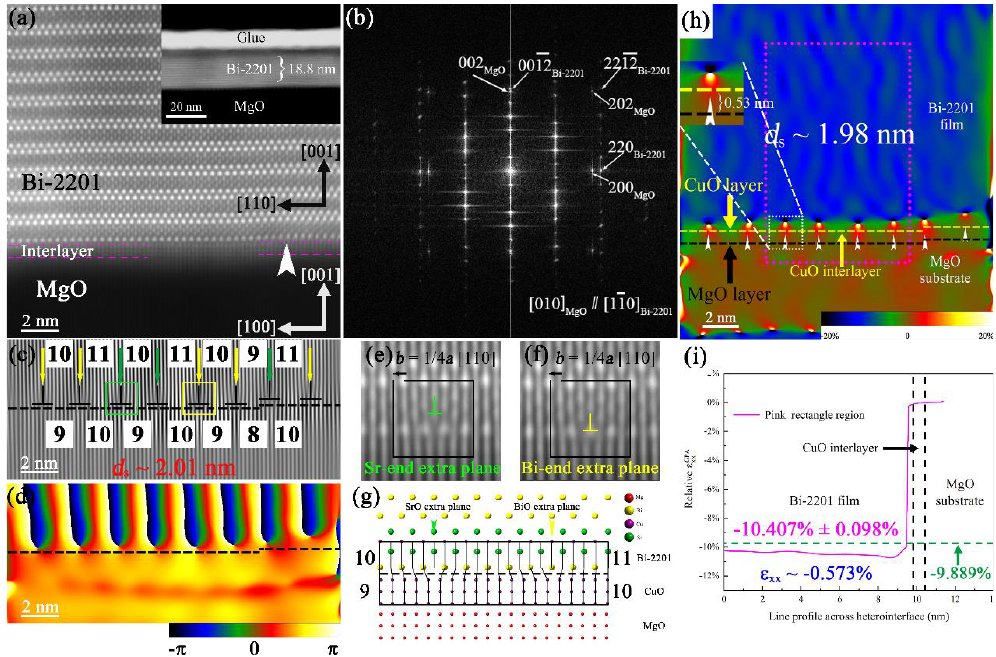
Figure 3. ( a ) HAADF image of the MgO/Bi-2201 heterointerface. ( b ) FFT image of ( a ). ( c ) (200)MgO Bragg and ( d ) geometric phase image of ( a ). Enlarged areas of the green ( e ) and yellow ( f ) squares in ( c ). ( g ) Schematic diagram of 9 or 10 (200)CuO lattices match with 10 or 11 (220)Bi-2201 lattices. ( h ) The ε xx map of ( a ). ( i ) ε xx along the length of the pink rectangle area in ( h ). Reprinted with permission from Ref. [29]. Copyright 2021,